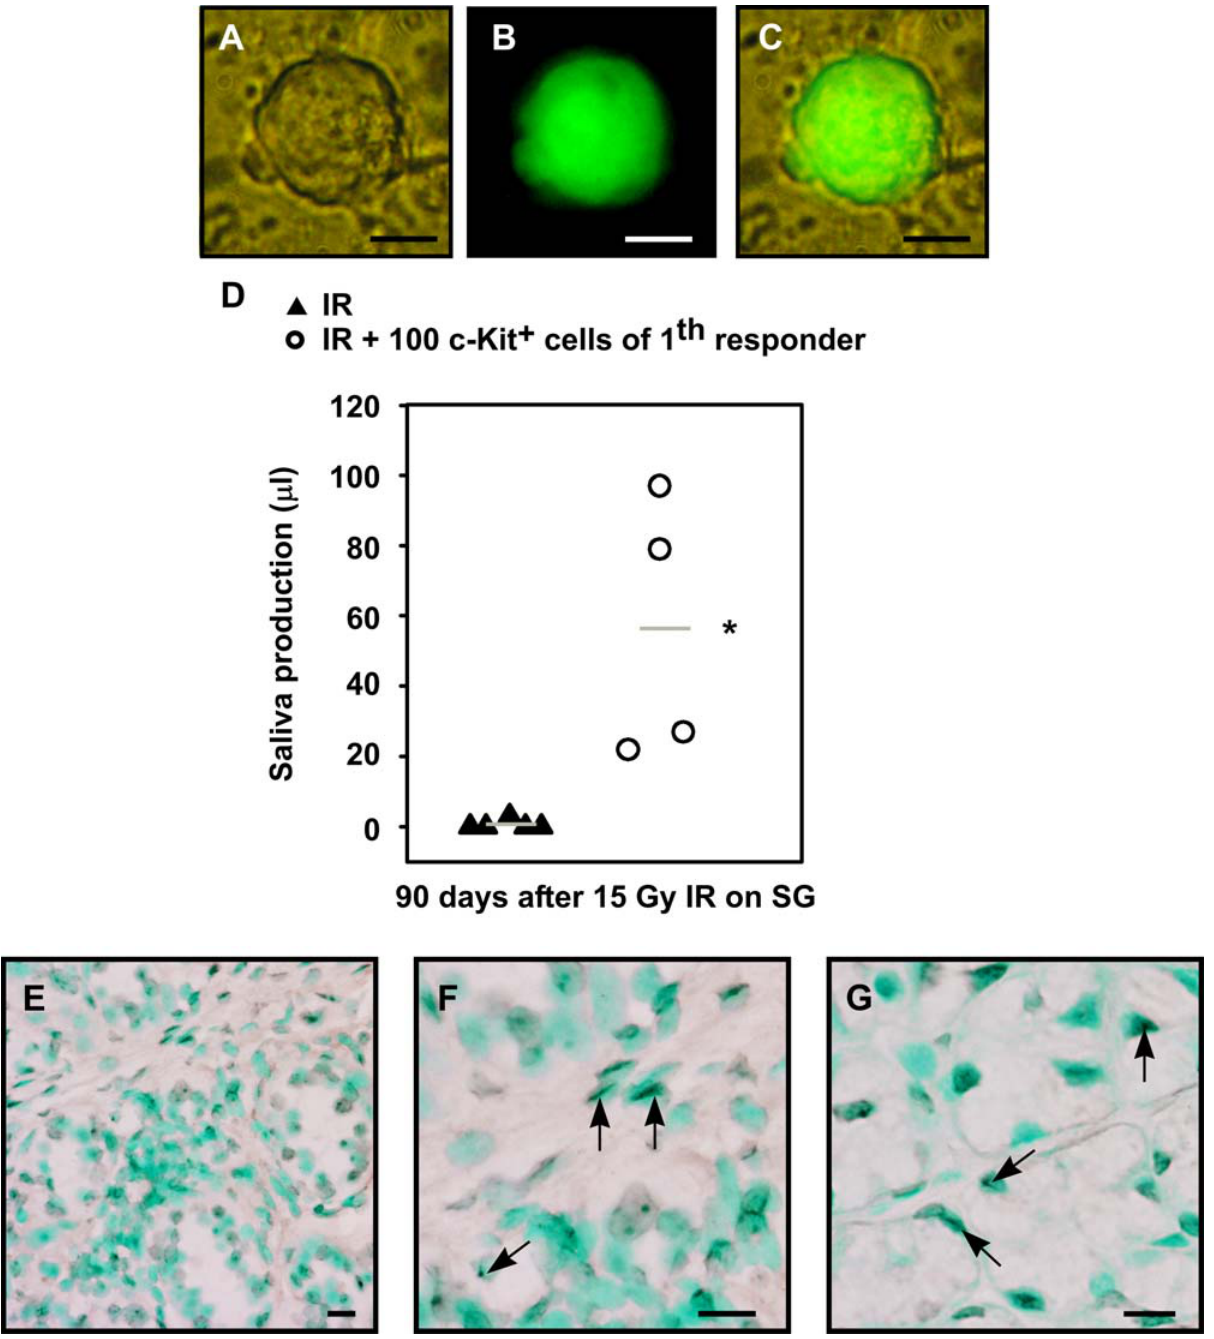
Figure 7. Restored organ function by transplantation of c-kit + cells from secondary spheres in secondary recipients. Primary recipients were sacrificed 120 days after transplantation and secondary spheres were cultured from isolated glands. (A) Bright field image of secondary sphere, (B) GFP expression of this sphere, (C) overlay. (D) c-Kit + cells were re-isolated from secondary salispheres and 100 cells were serially transplanted into irradiated gland of secondary recipients. Saliva production of secondary recipients was significantly ( P , 0.01) increased compared to irradiated control mice. (E,F,G) In situ hybridization to detect precence of Y chromosomes in male secondary transplanted cells in female recipient mice. Both ductal cells (F, arrows) and acinar cells (G, arrows) were Y chromosome + . Nuclei are visualized in green. Scale bar is 50 m m (E), or 20 m m (F,G). doi:10.1371/journal.pone.0002063.g007 salivary stem cells is restricted in the current culture system. age of cells expressing common stem cell markers Sca-1, c-Kit and Musashi-1 decreased in time. We were unable to generate secondary spheres from the initial spheres, as has been shown for other tissues. This indicates that the self-renewal capacity of the